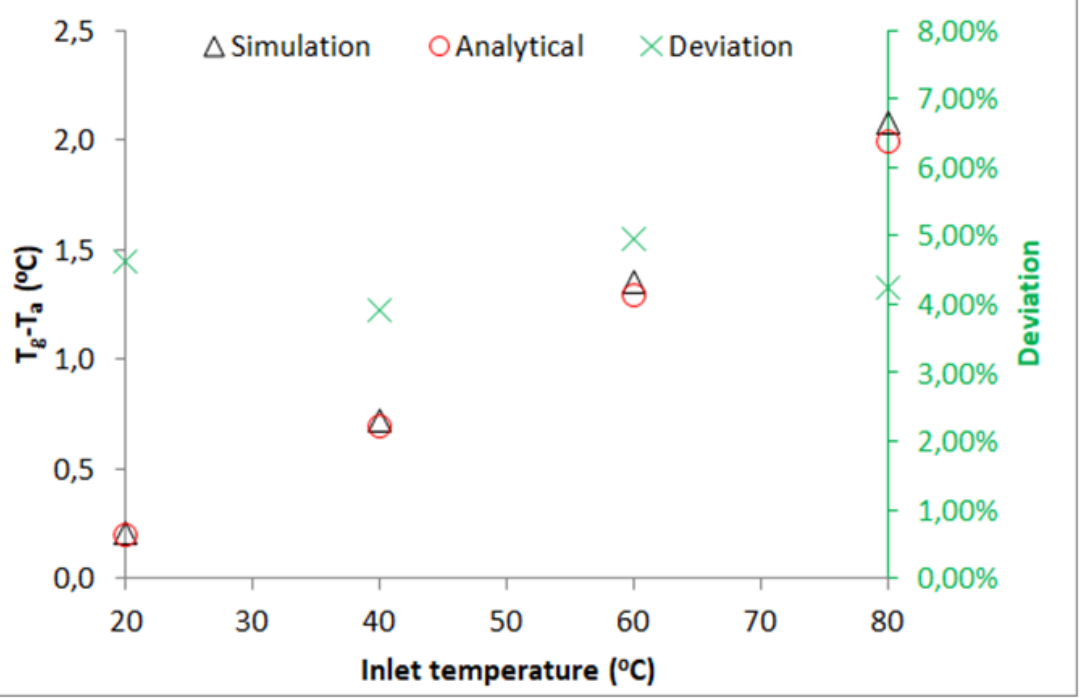
Figure 7. Verification regarding the temperature difference between the cover and the fluid in the inlet.